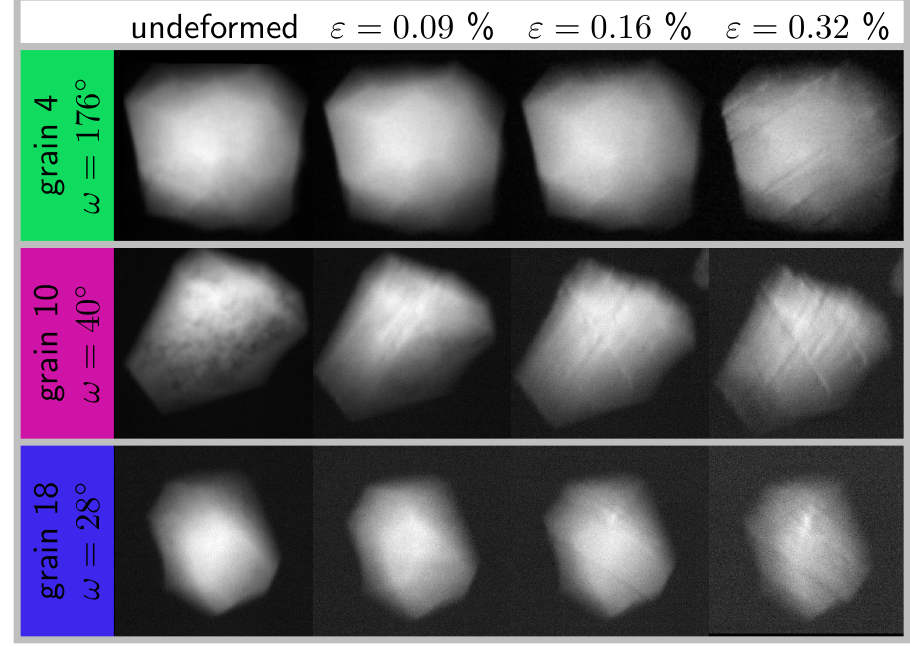
Figure 5. Topographs, integrated over Θ , in edge-on configuration for each grain of the cluster and different load levels; videos of the complete ω set are available as Supplementary Material for Grain 4 in the initial and deformed